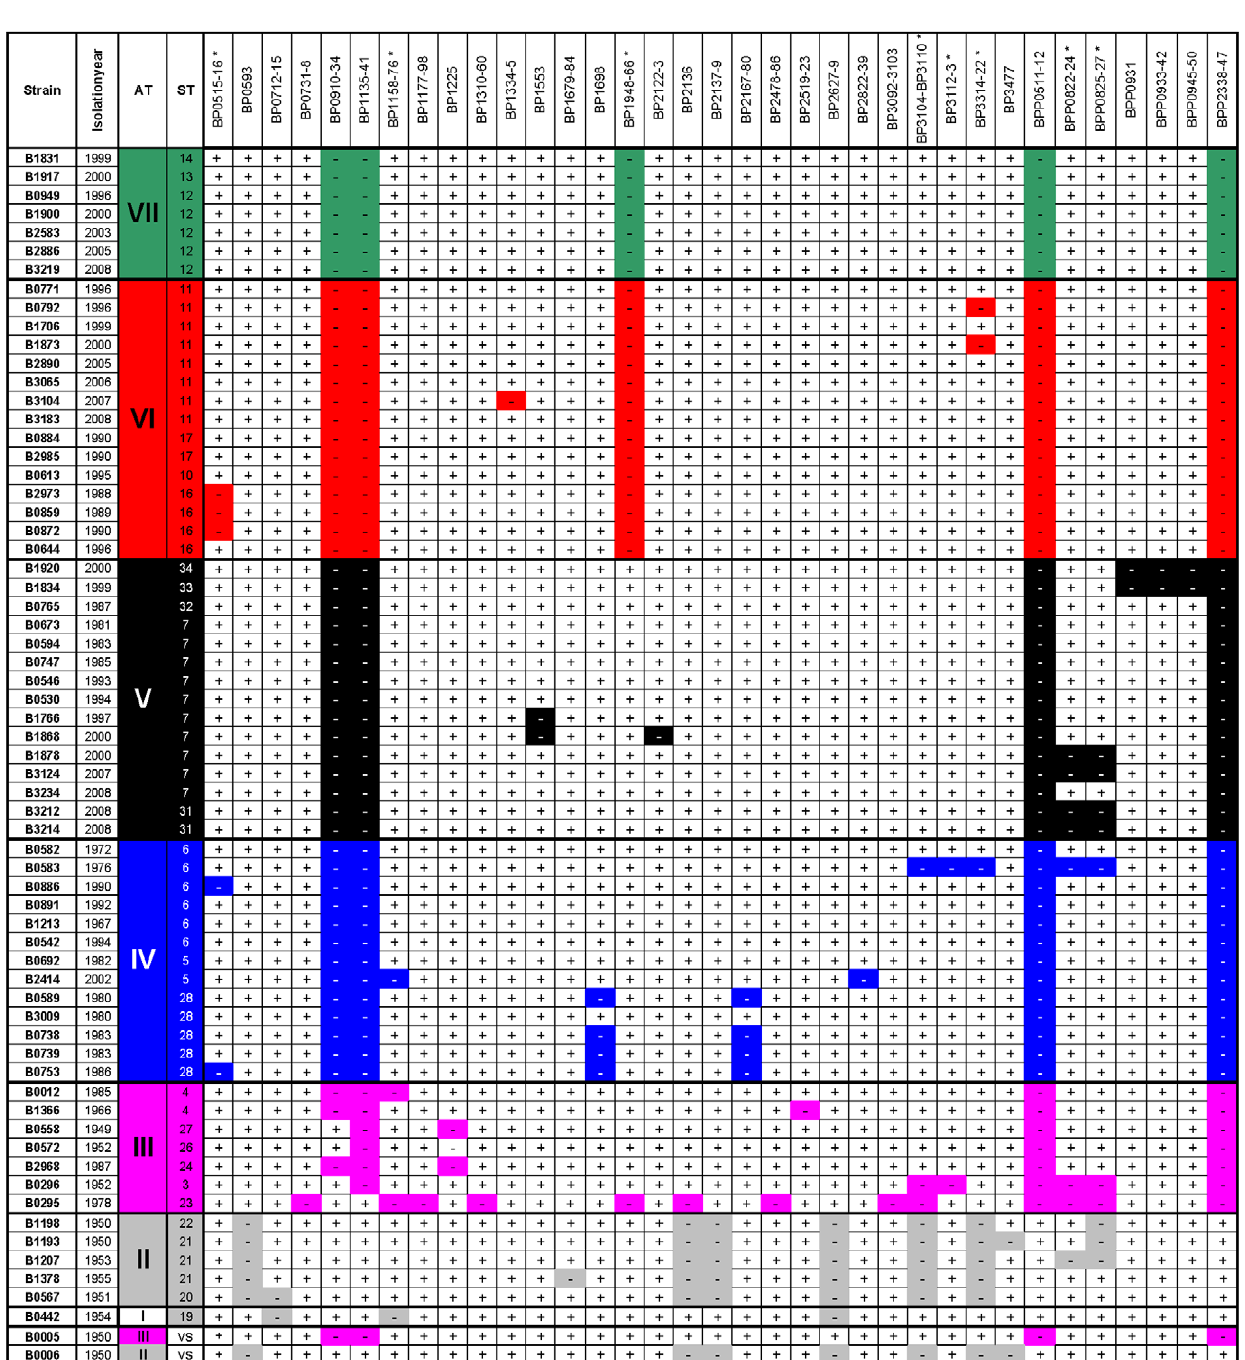
Figure 4. Relationship between phylogeny and gene loss. Strains with their corresponding allele type (AT) and sequence type (ST) are shown in the left columns. Strains were clustered according to their position in the phylogenetic tree as shown in Fig. 1. Colouring of ATs is as in Fig. 1. DNA loci with corresponding gene designations [46] are shown in the top row. The two strains used for the Dutch whole cell vaccine, B0005 and B0006, are indicated in the two bottom rows. Absence and presence of DNA loci are indicated by + and 2 , respectively and deletions showing homoplasy are indicated with asterisks in the top row. Abbreviations: AT, allele type; ST, sequence type; VS, vaccine strain used for the Dutch WCV.